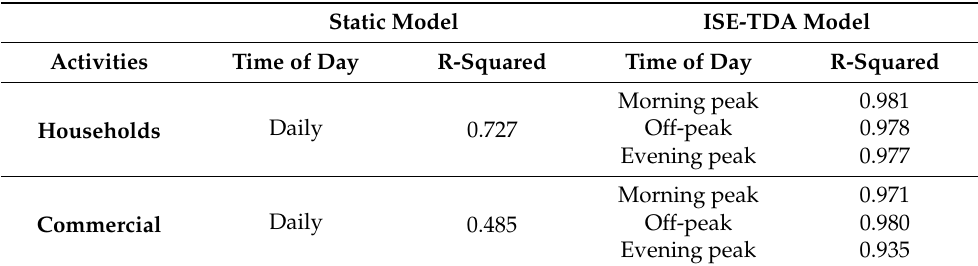
Table 8. Comparison between static and ISE-TDA